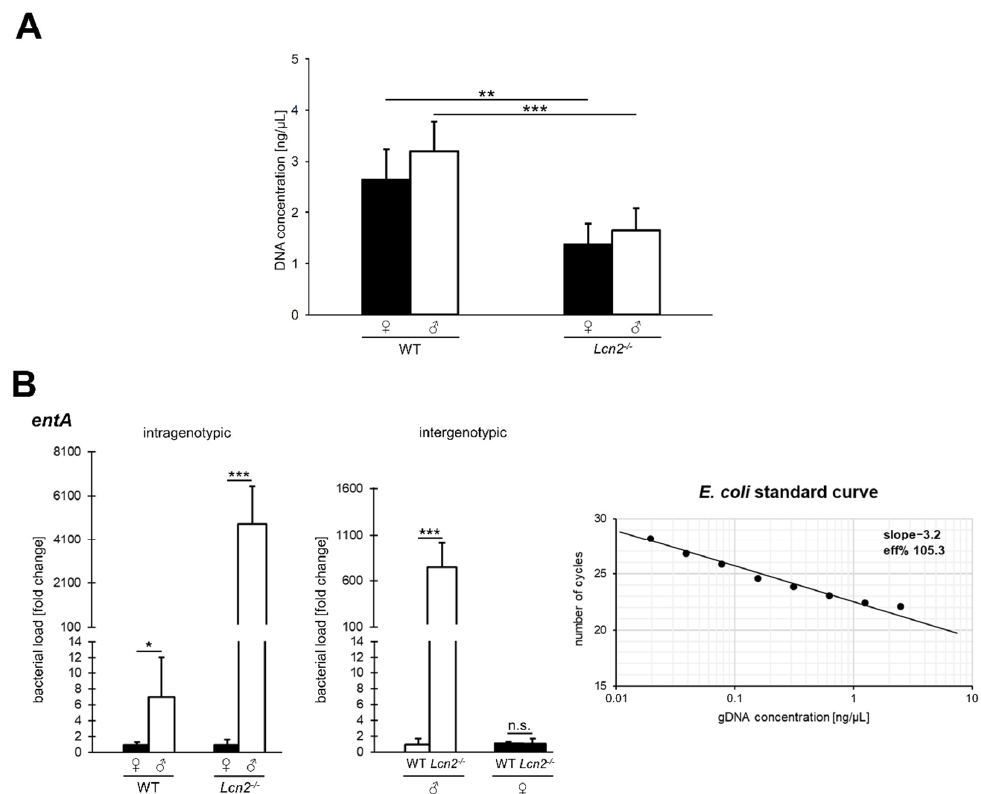
Figure 1. Concentration of total and intestinal DNA abundance in murine feces. ( A ) After extraction, the dsDNA con- centration was fluorometrically determined by Qubit ® assay. The bars represent the arithmetic mean of the individual measurements (± SD; Lcn2 -/- (n = 7 or 5) and wild type mice (n = 7 or 3)). Statistical evaluation was performed by an unpaired t -test, whereby the difference of two samples from a level of p < 0.05 is considered statistically significant (**: p < 0.01, ***: p < 0.001). ( B ) Investigation of the intestinal abundance of entA -coding bacteria using qPCR. The data were normalized using an E. coli standard curve ( right ). Grouped bars represent the fold change ratio between two data sets (± SD; Lcn2 -/- (n = 7 or 5) and wild type mice (n = 7 or 3)), with the wild type defined as 100%. Statistical evaluation was performed by unpaired t -test, whereby the difference between two samples from a level of p < 0.05 is considered statistically significant (*: p < 0.05, ***: p < 0.001; n.s. = not significant; Eff% = efficiency [%]).